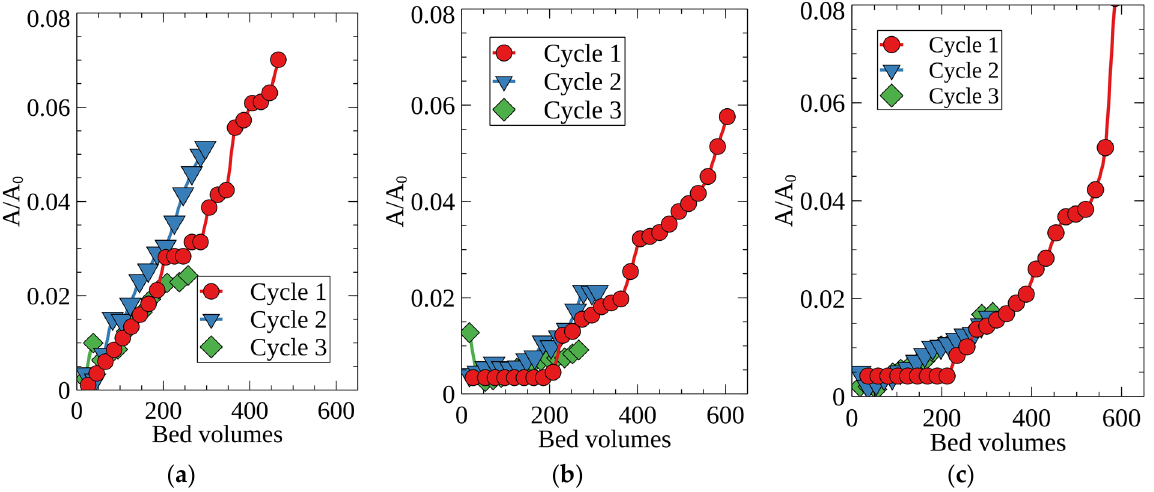
Figure 8. Breakthrough curves of Cs-137 sorption from the model solution No. 2. under dynamic conditions in three successive sorption cycles; ( a ) RFR, ( b ) RFR-Ca, ( c ) RFR-T, grain size 0.2–0.5 mm, solution flow rate—50 BV/h.